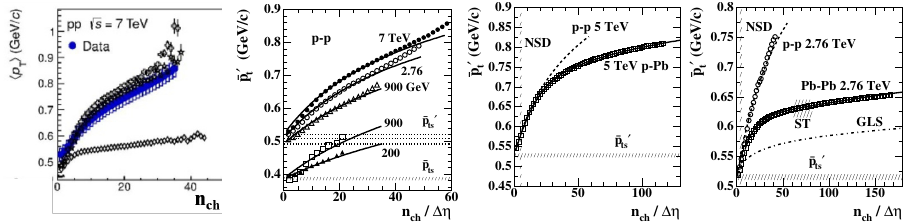
Figure 3. First: ALICE ¯ p t data (solid points) compared to PYTHIA predictions (open points). Second: ¯ p t data (points) compared to TCM trends (curves). Third: ALICE ¯ p t data for 5 TeV p -Pb collisions (points) compared to a TCM trend (solid curve). Fourth: ALICE data for 2.76 TeV Pb-Pb collisions (open boxes) compared to a TCM trend (solid